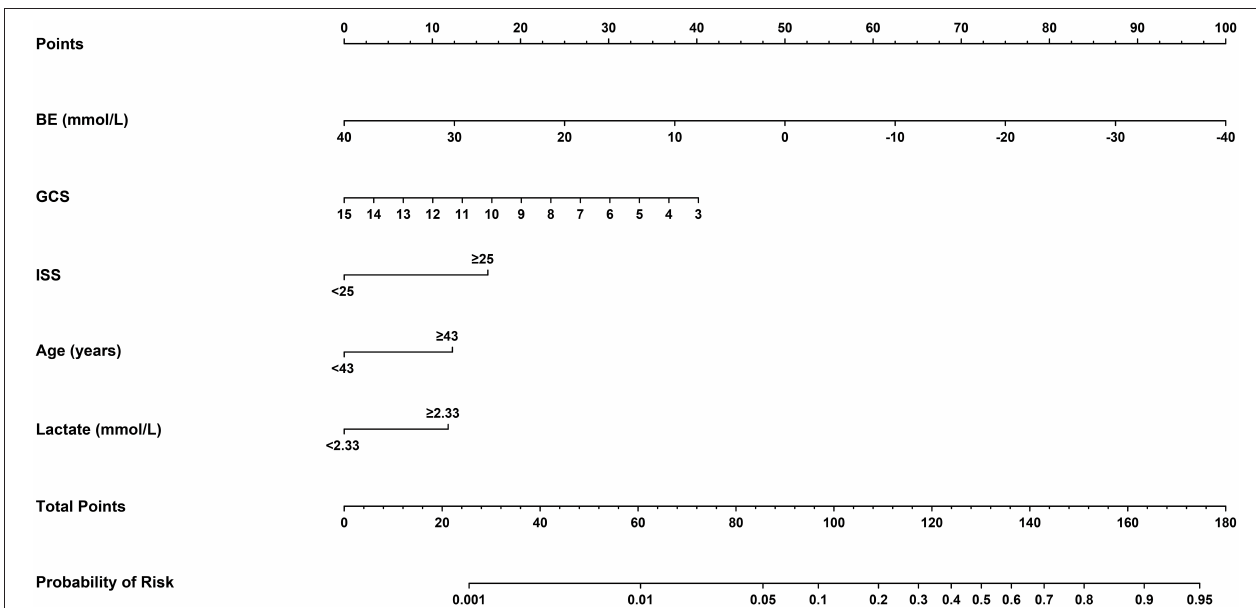
FIGURE 2 | Nomogram for estimating the risk of 72-h mortality after admission in patients with polytrauma. Using a nomogram, we first determined the location of the axis corresponding to each variable and drew a vertical line to the “Points” axis to get a score, then, summed scores from all variables, and drew another vertical line from the “Total Points” axis to the “Probability of Risk” axis for the predicted probability. BE, base excess; GCS, Glasgow Coma Scale; ISS, injury severity